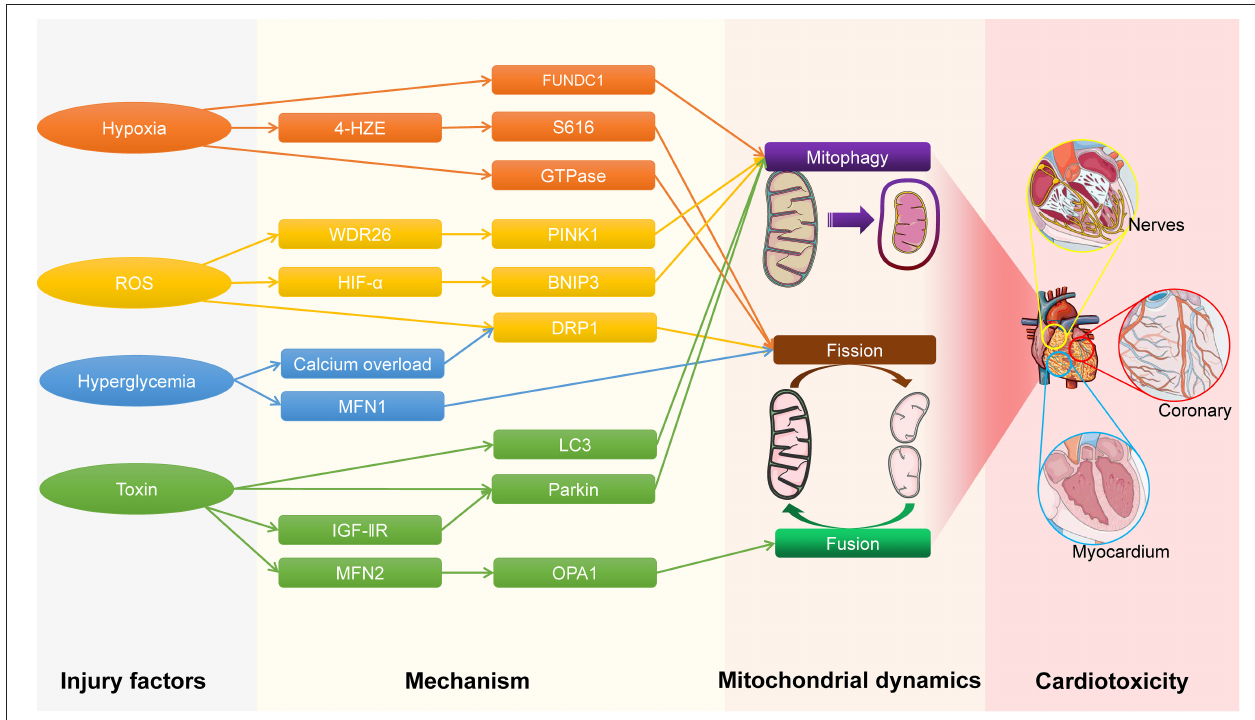
FIGURE 1 | The process of cardiotoxicity caused by different injury